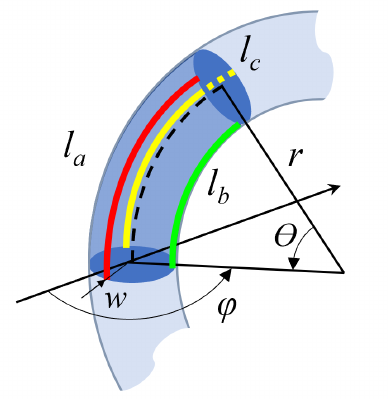
Figure 3. Parameters for a section of a constant curvature